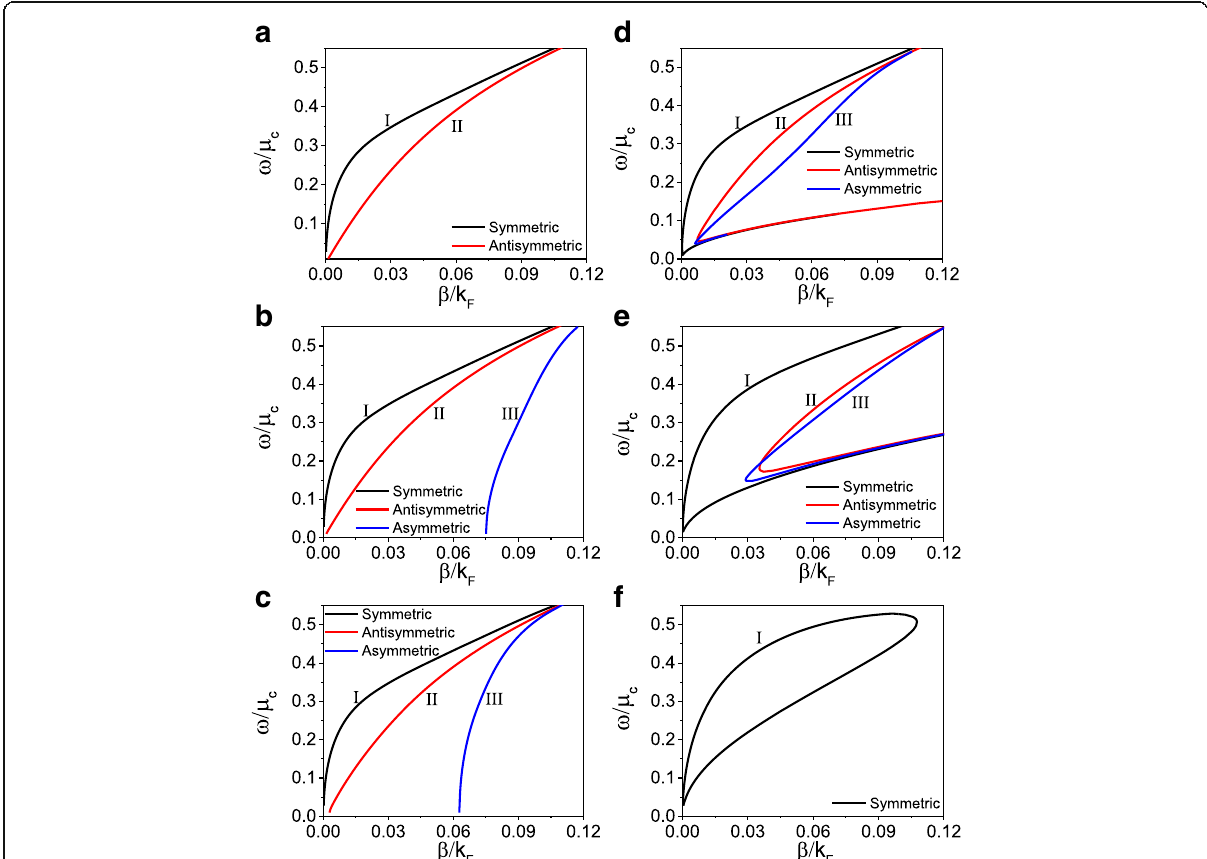
Fig. 4 The dispersion relation for a fixed initial magnetic intensity ( H 0 = 300 A/m) and for various nonlinear coefficient( a – c ) and for various chemical potential( d – f ). a α = 0, μ c = 0.27eV, σ NL = 0, b α = 5 × 10 − 17 (m/V) 2 , μ c = 0.27eV, σ NL = 0, c α = 5 × 10 − 16 (m/V) 2 , μ c = 0.27eV, σ NL = 0, d μ c = 0.27eV, α = 5 × 10 − 16 (m/V) 2 , ( e ) μ c = 0.16eV, α = 5 × 10 − 16 (m/V) 2 , and f μ c = 0.10eV, α = 5 × 10 − 16 (m/V)